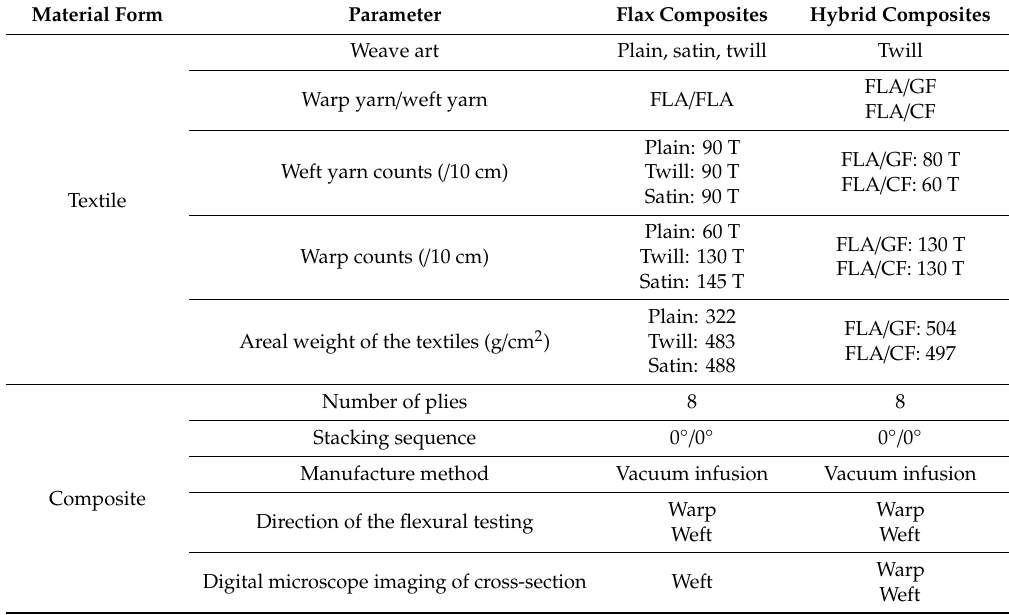
Figure 3. Schematic representation of the twill patterned hybrid textiles (from left to right): flax, flax-/glass, and flax-/carbon. Table 3. Overview of the parameters used in this study during textile and composite manufacture as well as testing.